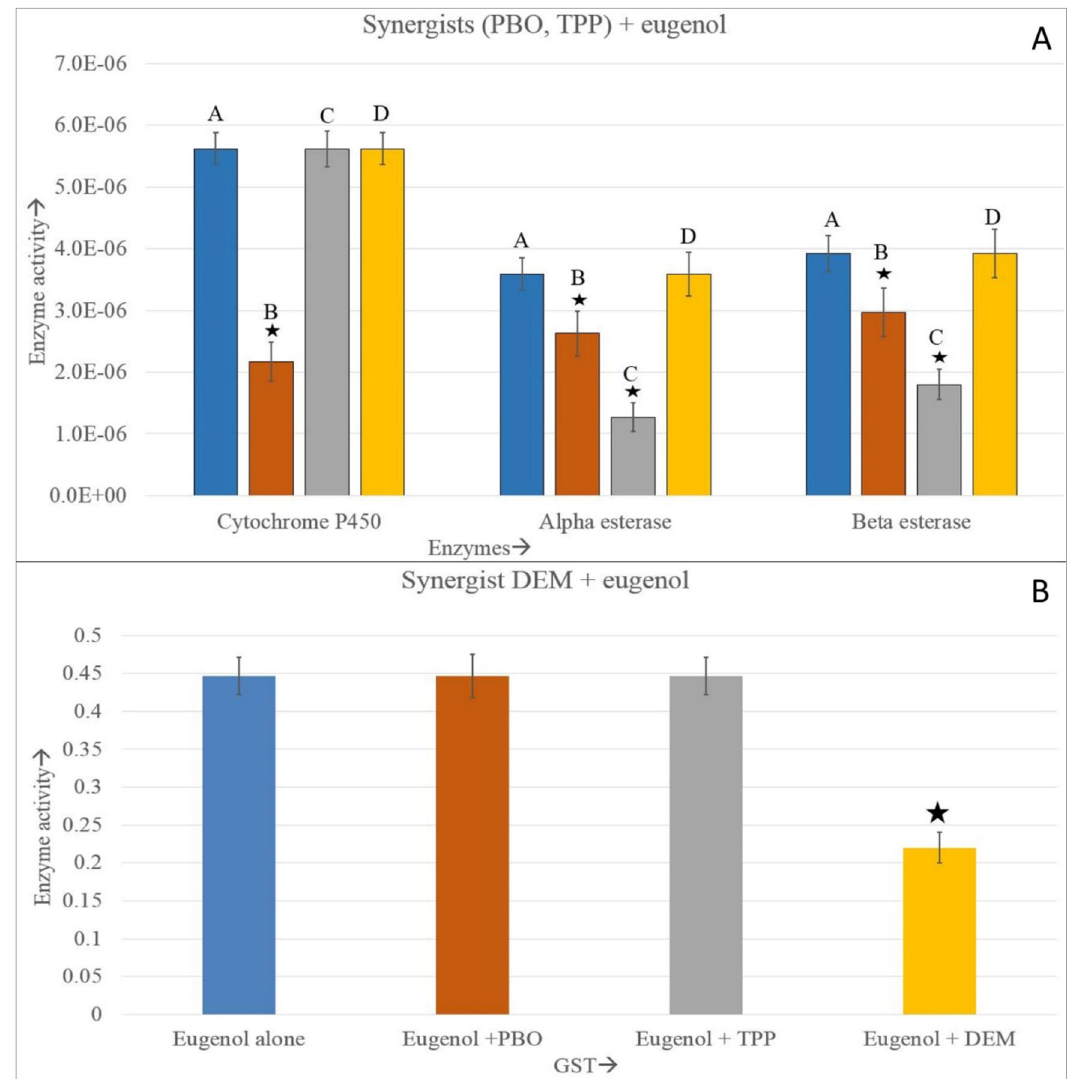
Figure 7. Effect of synergists (PBO, TPP and DEM) on the metabolic detoxification enzymes- esterases, GST and cytochrome P450 of A. aegypti . Asterisks represents the significance in difference and both directional vertical bar at the tip of each enzyme bar represents the error bars. Enzyme activity of esterases, cytochrome p450, and GST are expressed at the unit of μM of product formed/min/mg protein, cytochrome P450/min/mg protein, and mM of conjugate produced/min/mg protein,